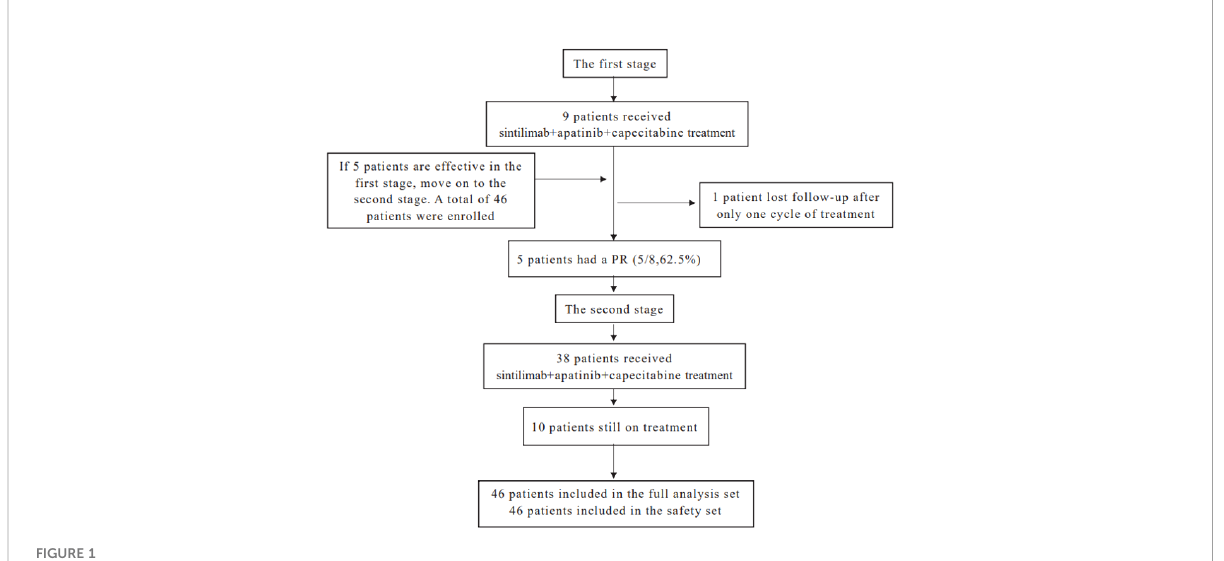
FIGURE 1 Trial fl ow